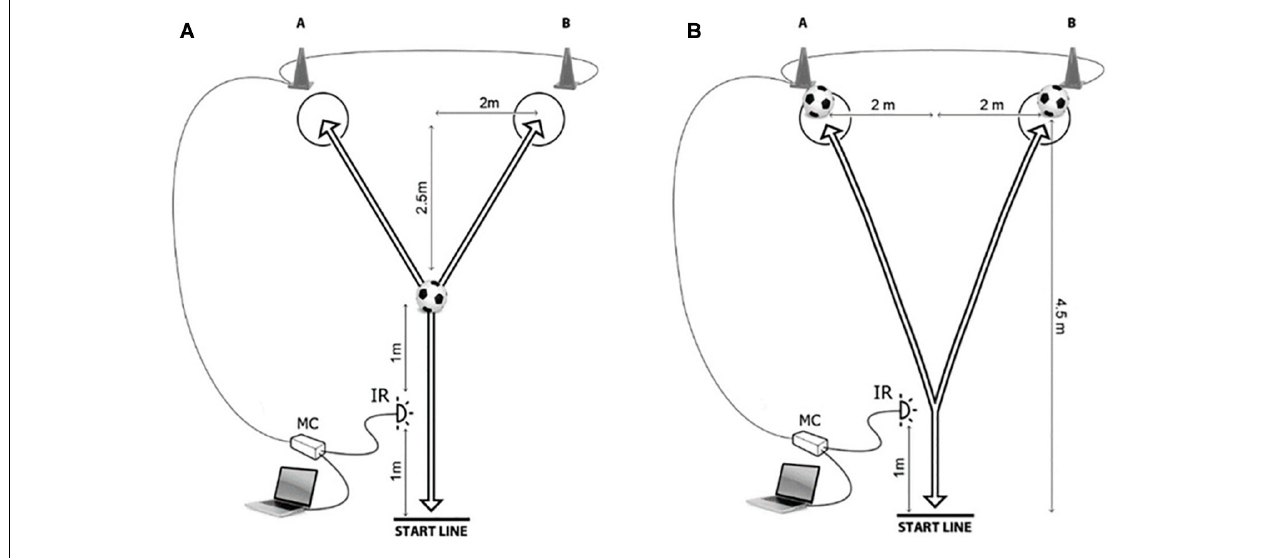
FIGURE 1 | Testing of the futsal specific agility and change of direction speed with dribbling the ball (A) and without dribbling the ball (B) .